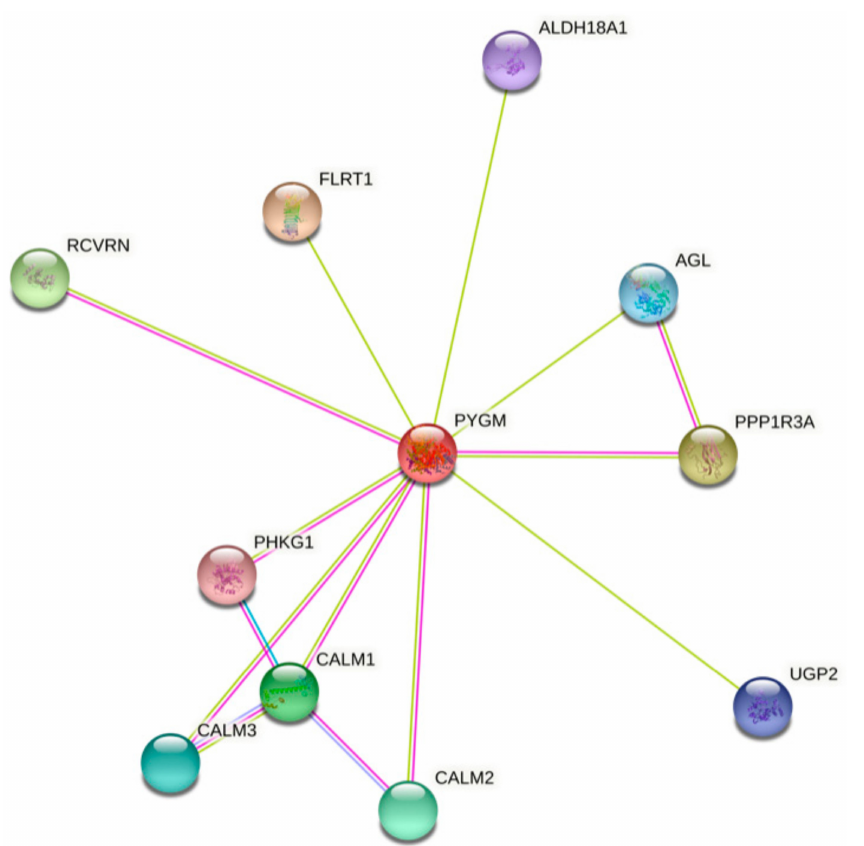
Figure 1. The human muscle glycogen phosphorylase (PYGM) protein–protein interaction network. The prediction, based on text mining, experiments, and databases, of possible PYGM associations. The edges indicate that the proteins are part of a physical complex. Four differently colored lines represent four types of evidence. A pink line indicates the experimentally determined interactions; light blue—database evidence; green—text mining evidence; dark blue—gene co-occurrence. ALDH18A1—aldehyde de- hydrogenase 18 family member A1; AGL—amylo-alpha-1,6-glucosidase, 4-alpha-glucanotransferase; CALM1, 2, 3—calmodulin 1, 2, 3; FLRT1—fibronectin leucine rich transmembrane protein 1; PHKG1— phosphorylase kinase catalytic subunit gamma 1; PPP1R3A—protein phosphatase 1 regulatory subunit 3A; RCVRN—recoverin; UGP2—UDP-glucose pyrophosphorylase 2. According to the Protein–Protein Interaction Networks Functional Enrichment Analysis, STRING (accessed on 4 February 2021)